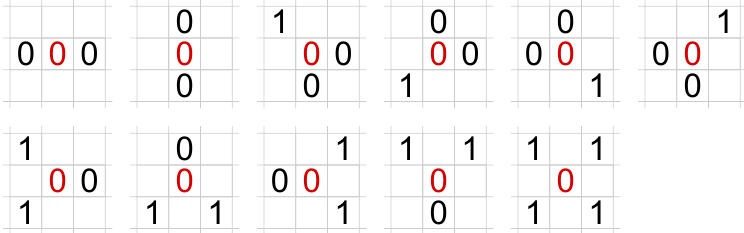
Figure 10: If a spin in red is surrounded by one of the presented local configurations of spins in black, it cannot be immediately flipped. Only half of the configurations is shown. The second half is obtained by a global spin flip, 0 ↔ 1 (22 configurations in total).